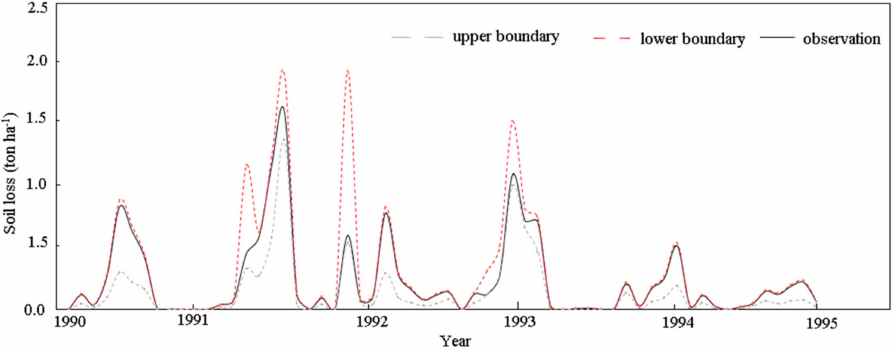
Figure 4. Uncertainty analysis of VIC-WEPP model in simulating soil loss at Waseca, MN.